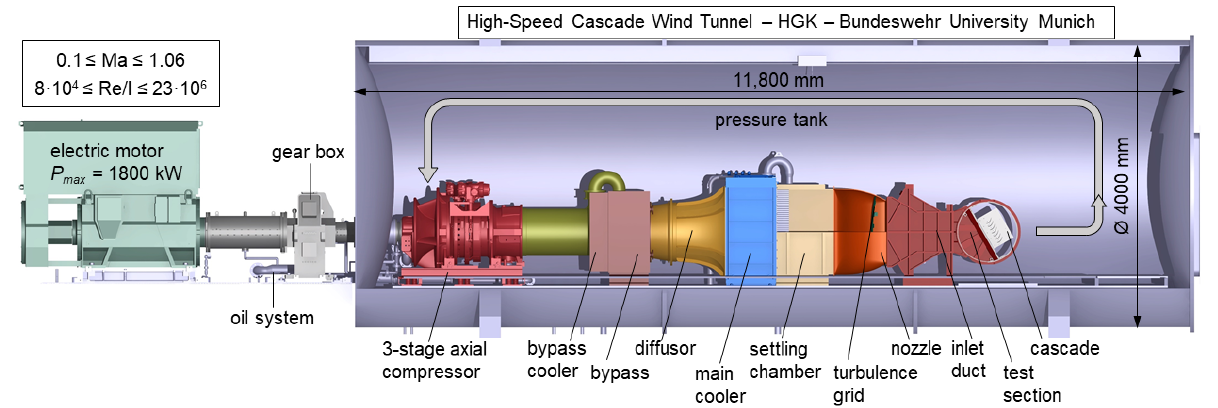
Figure 3. Main components of the High-Speed Cascade Wind Tunnel after revision.